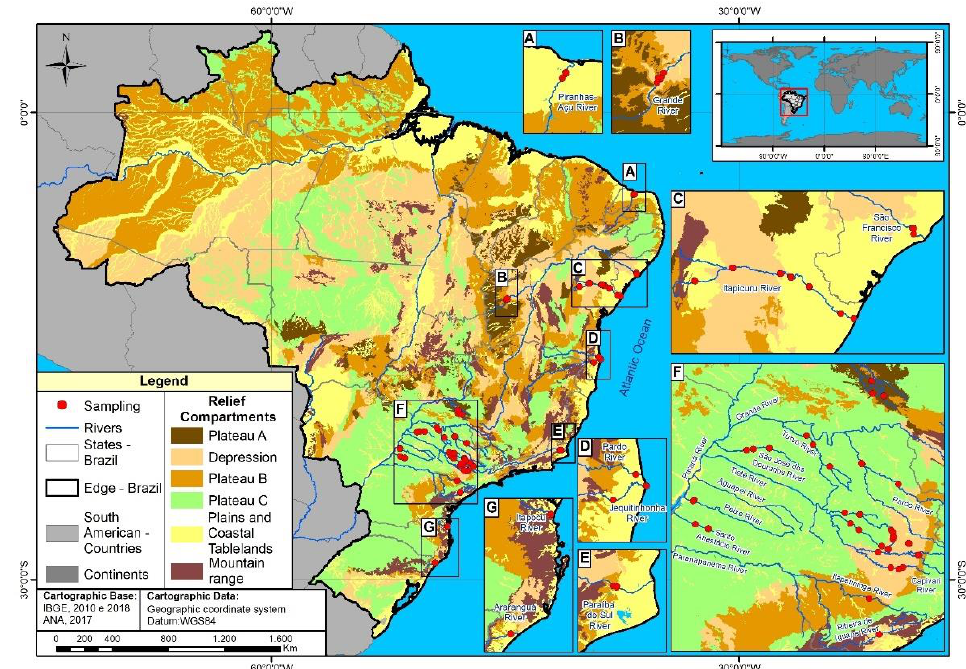
Figure 1. Location of sampling sites. ( A ) Low river terraces in the Piranhas-Açu river, Rio Grande do Norte state. ( B ) Low river terraces in the Grande river, Bahia state. ( C ) Low river terraces in the São Francisco river, Sergipe and Alagoas states, and the Itapicuru River, Bahia state. ( D ) Low river terraces in the Itapicuru, Una, Pardo, and Jequitinhonha rivers, Bahia state. ( E ) Low river terraces in the Paraíba do Sul river, Rio de Janeiro state. ( F ) Low river terraces in different rivers in the state of São Paulo. ( G ) Low river terraces in the Araranguá and Itapocu rivers, Santa Catarina state.